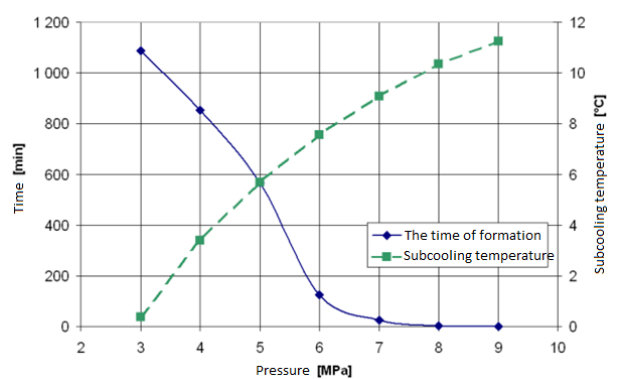
Figure 5. Dependence of hydrate formation time on pressure at 1ºC (Kim, 2009).